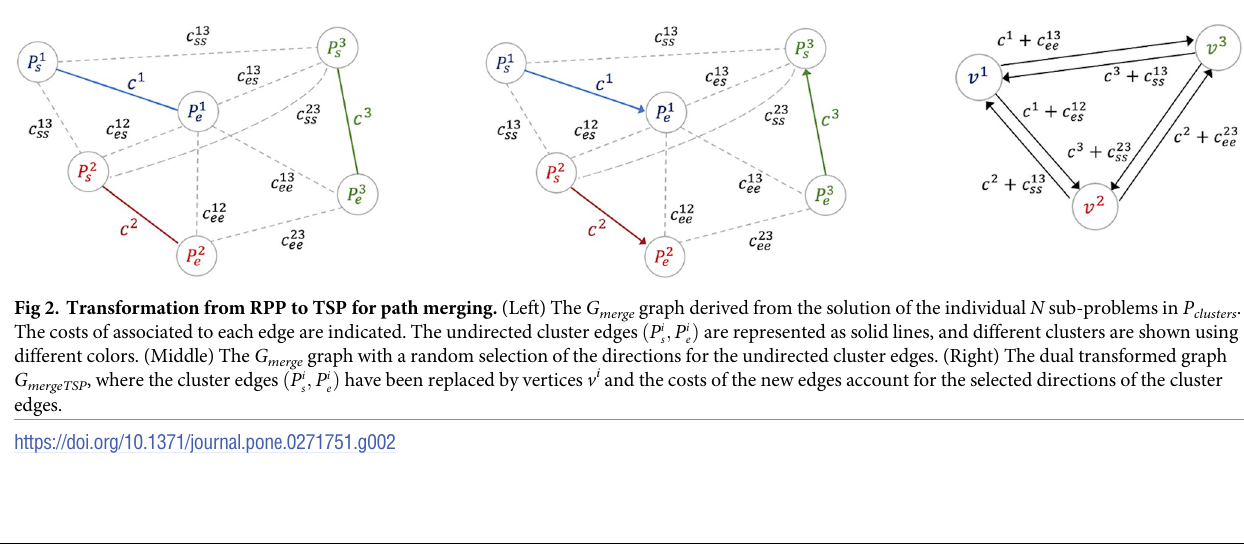
; P i Þ have been replaced by vertices v i and the costs of the new edges account for the selected directions of the cluster s e